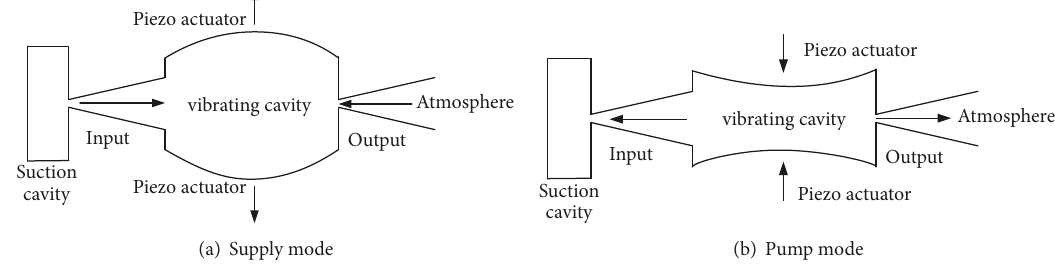
Figure 2: Working principle of the micropump suction cup.